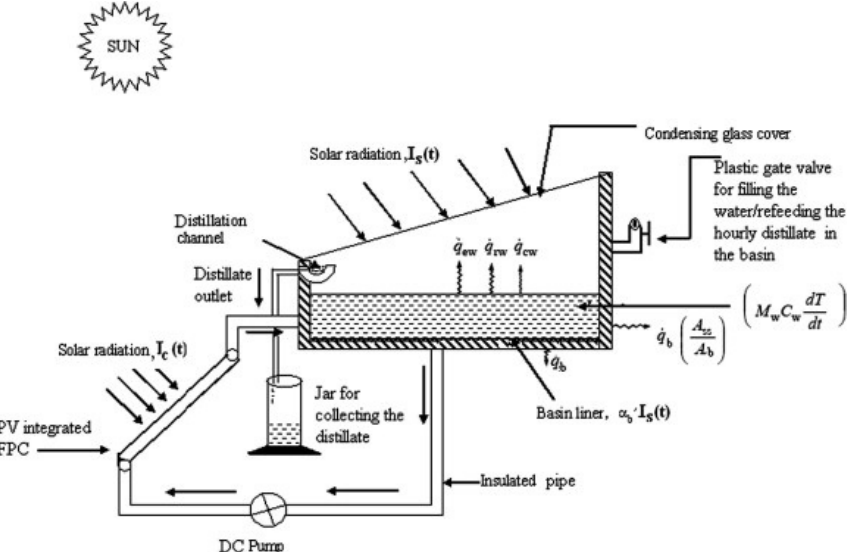
Figure 9. Schematic diagram of PV/T hybrid active solar still